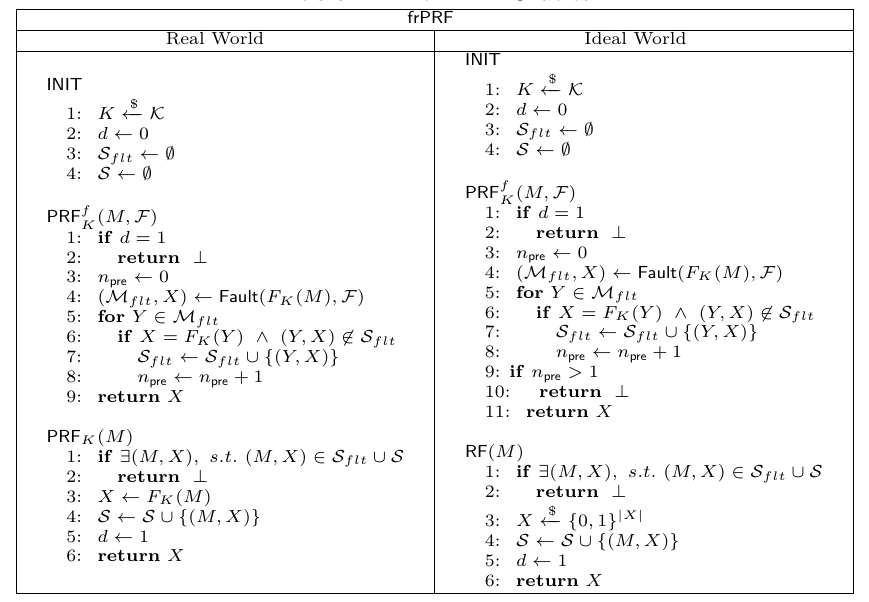
Table 4: The frPRF Oracles frPRF Real World Ideal